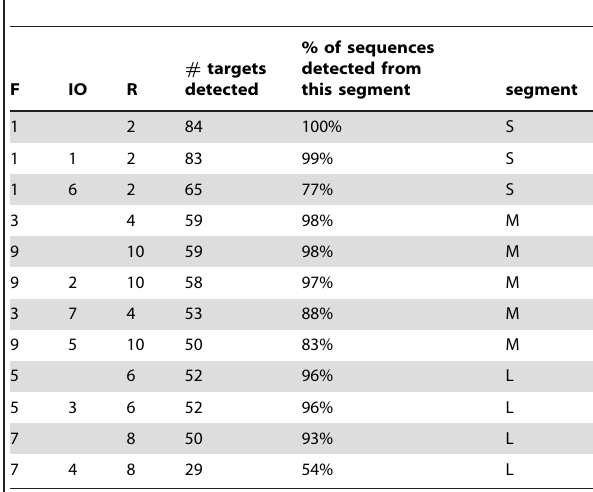
F,P, and IO numbers refer to the sequences in Table 3.